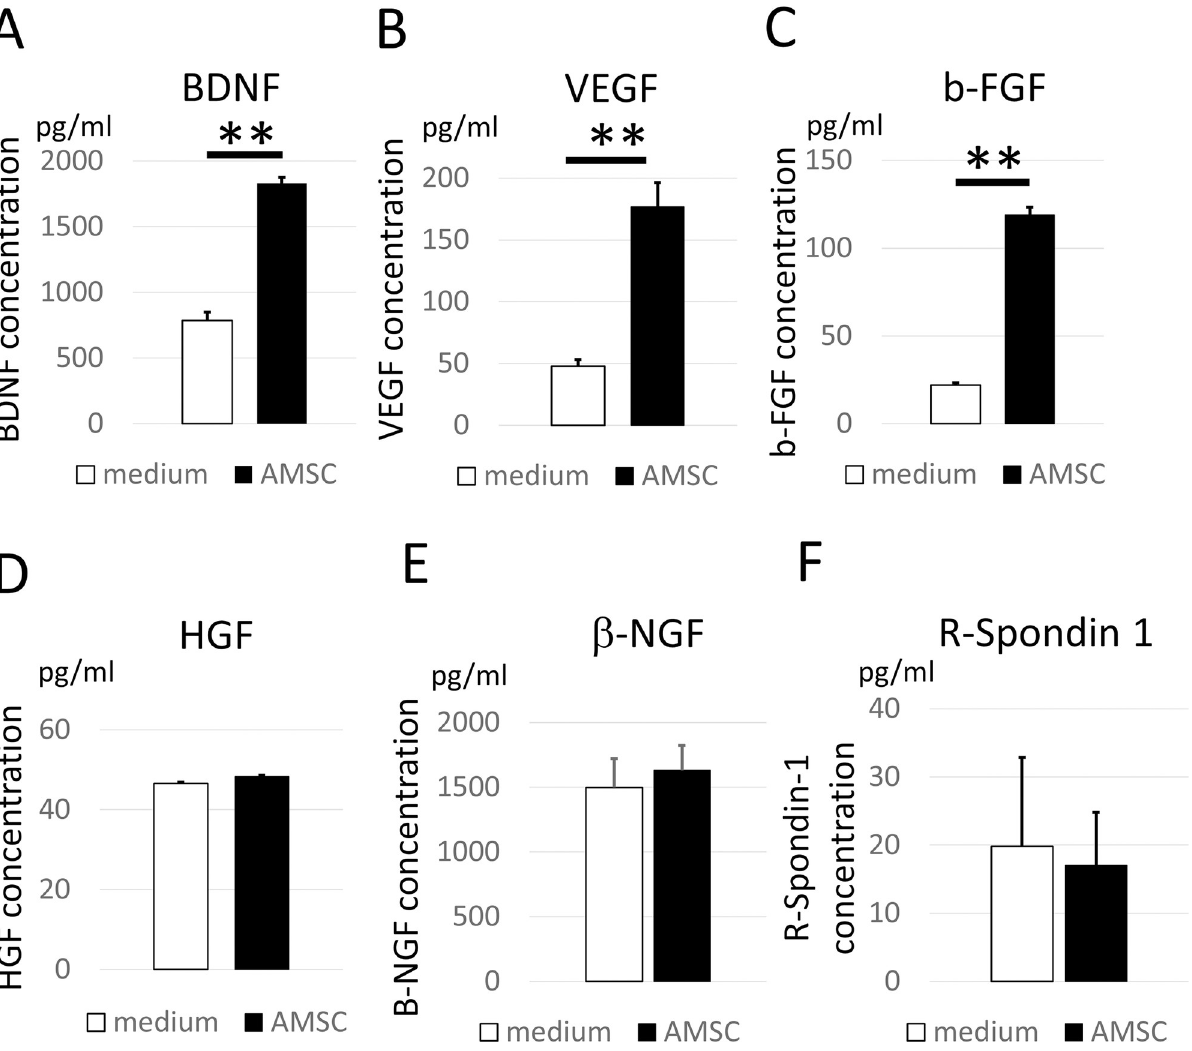
Fig 1. AMSCs secreted neurotrophic factors in vitro . The ability of AMSCs to secrete trophic factors was evaluated using ELISA. Neurotrophic factors such as (A) BDNF, (B) VEGF, and (C) b-FGF were significantly secreted from AMSCs compared with the control medium. Other neurotrophic factors such as (D) HGF and (E) β -NGF were secreted from AMSCs in negligible amounts. Intestinal trophic factors (F) R-Spondin 1 were also barely secreted. Data are presented as the mean ± standard error (SE). �� , P < 0.01. AMSC, amnion-derived mesenchymal stem cell; BDNF, brain-derived neurotrophic factor; b-FGF, basic fibroblast growth factor; HGF, hepatocyte growth factor; NGF, nerve growth factor; VEGF vascular endothelial growth factor.